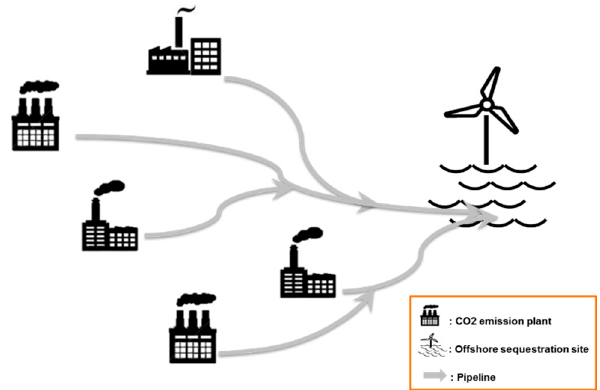
Figure 1. Typical CO 2 pipeline transportation network with direct source-sink connection.